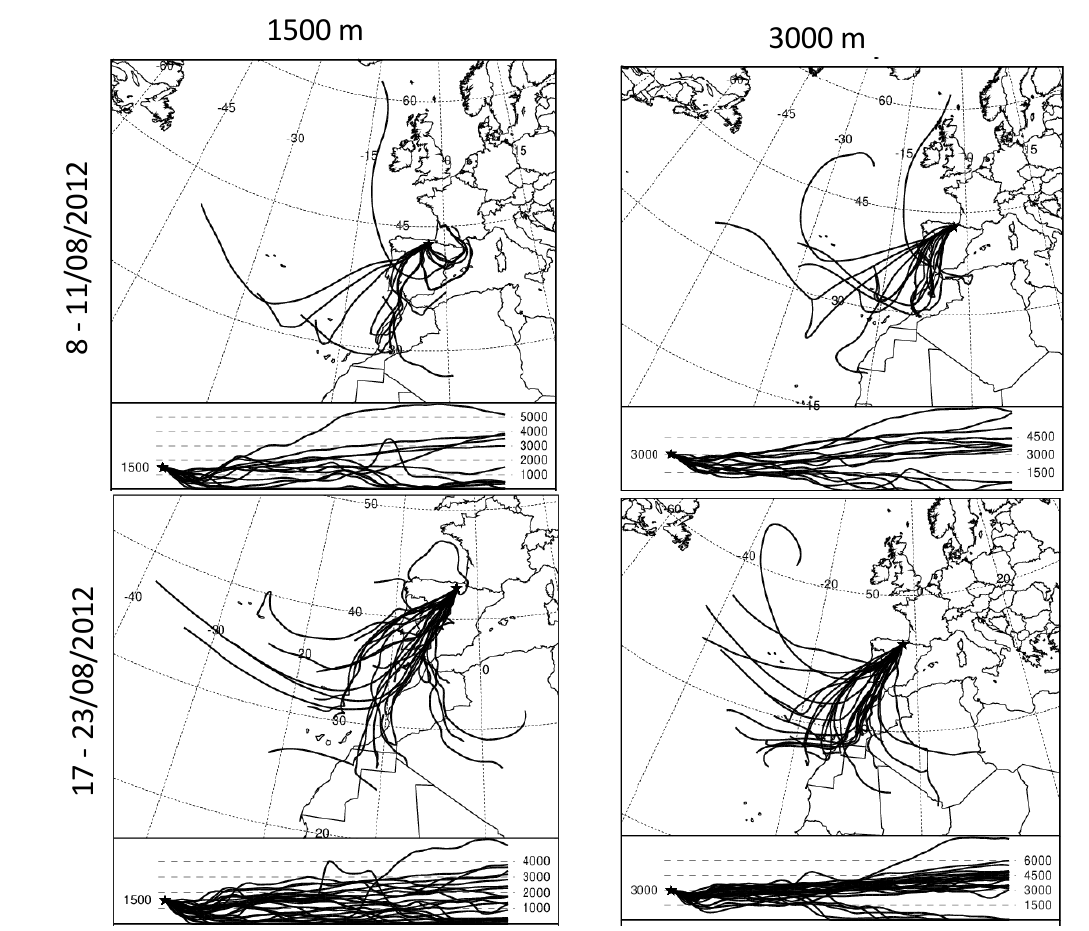
Figure 6. Atmospheric pressure map at 500 hPa and ground level (10/08/2012 and 20/08/2012), and the set of backward trajectories at 1500 m and 3000 m over Vitoria during both heat wave events.